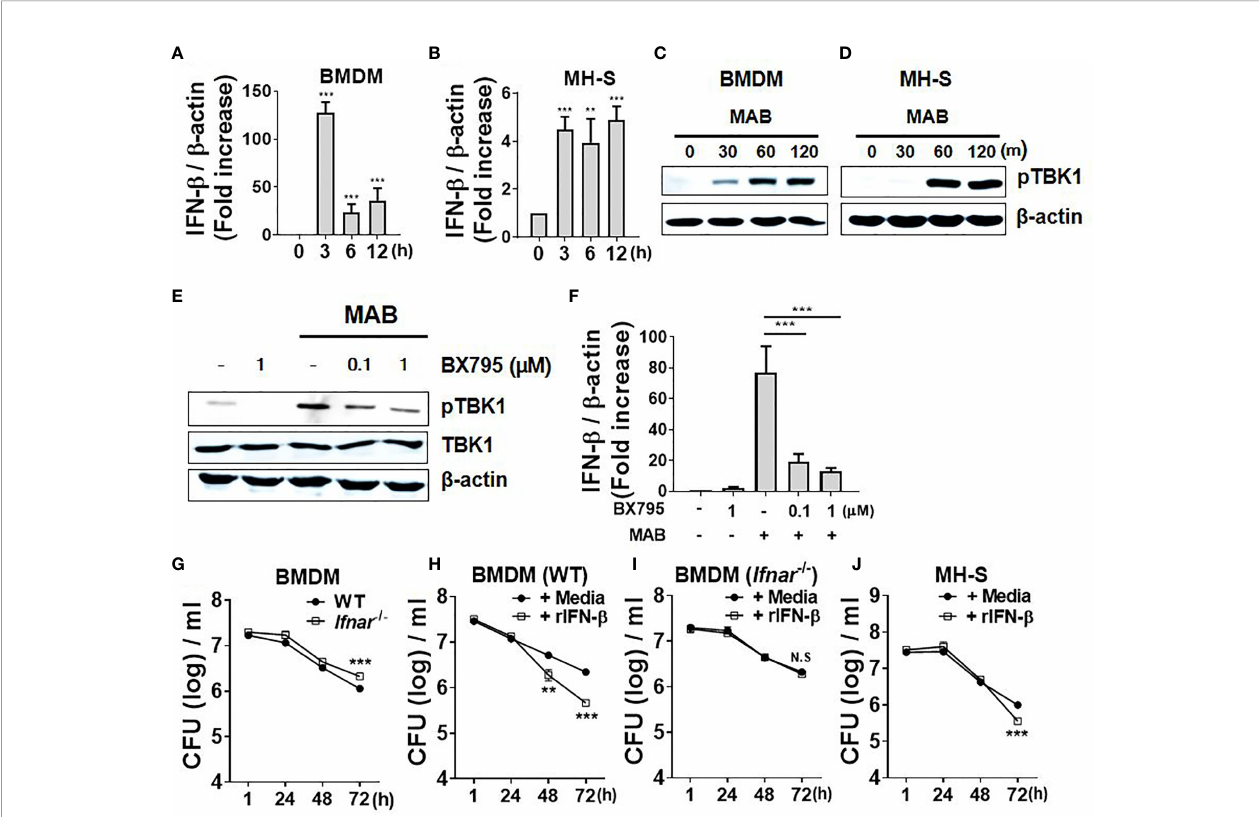
FIGURE 1 | MAB induces IFN- b gene expression of macrophages in TBK1-dependent manner, which promotes intracellular bacterial clearance. (A, B) BMDMs and mouse alveolar macrophage cell line MH-S cells were infected with MAB at multiplicity of infection (MOI) 1:25 for indicated times. mRNA was extracted, and the expression levels of IFN- b gene were determined by real-time PCR. (C) BMDMs and (D) MH-S cells were infected with MAB for indicated times. (E) BMDMs were infected with MAB for 1 h in the absence or presence of BX795 (2 h pretreated). (C – E) The levels of indicated proteins were determined by Western blotting. (F) BMDMs were infected with MAB for 6 h in the absence or presence of BX795 (2 h pretreated). The mRNA was extracted, and the expression levels of IFN- b gene were determined by real-time PCR. (G – J) Cells were infected with MAB in the absence or presence of recombinant IFN- b (1,000 units/ml, 2 h pretreated). Intracellular bacterial CFU on indicated times were evaluated by intracellular bacterial growth assay. (A – J) The results are from one representative experiment of two independent experiments (**p < 0.01, ***p < 0.001). MAB, Mycobacterium abscessus ; IFN, interferon; TBK1, TANK binding kinase 1; BMDMs, bone marrow-derived macrophages; CFU, colony-forming unit. NS, Not Statistically Signi fi